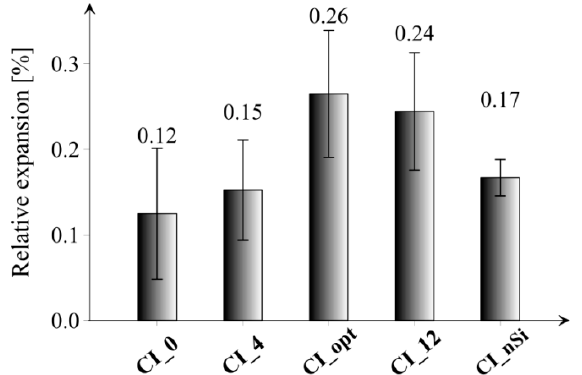
Figure 15. Results of ASR tests in the form of the relative increase in the length of the prismatic specimens of all tested series after 14 days of immersion in NaOH solution. Vertical bars indicate one standard deviation.